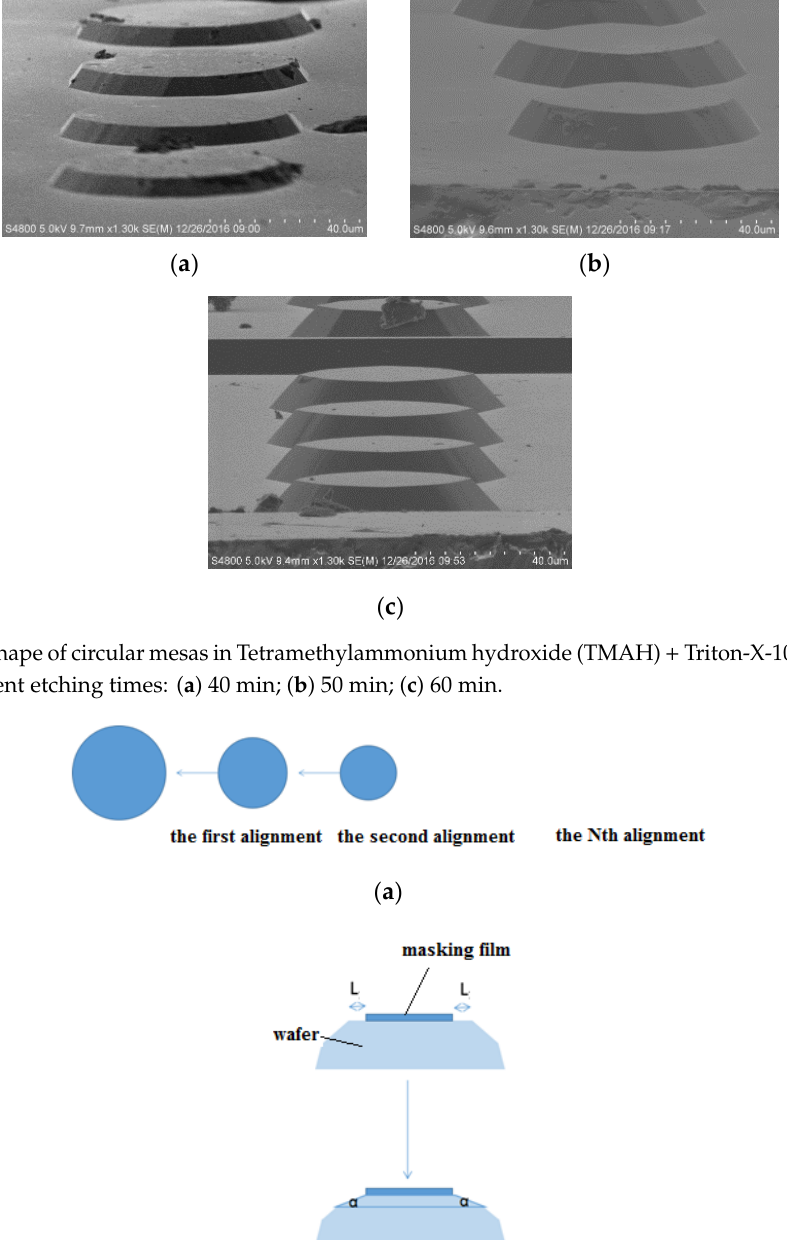
Table 1. Shape parameters of the circular mesas etched in Tetramethylammonium hydroxide (TMAH) + Triton-X-100 solution after different times.